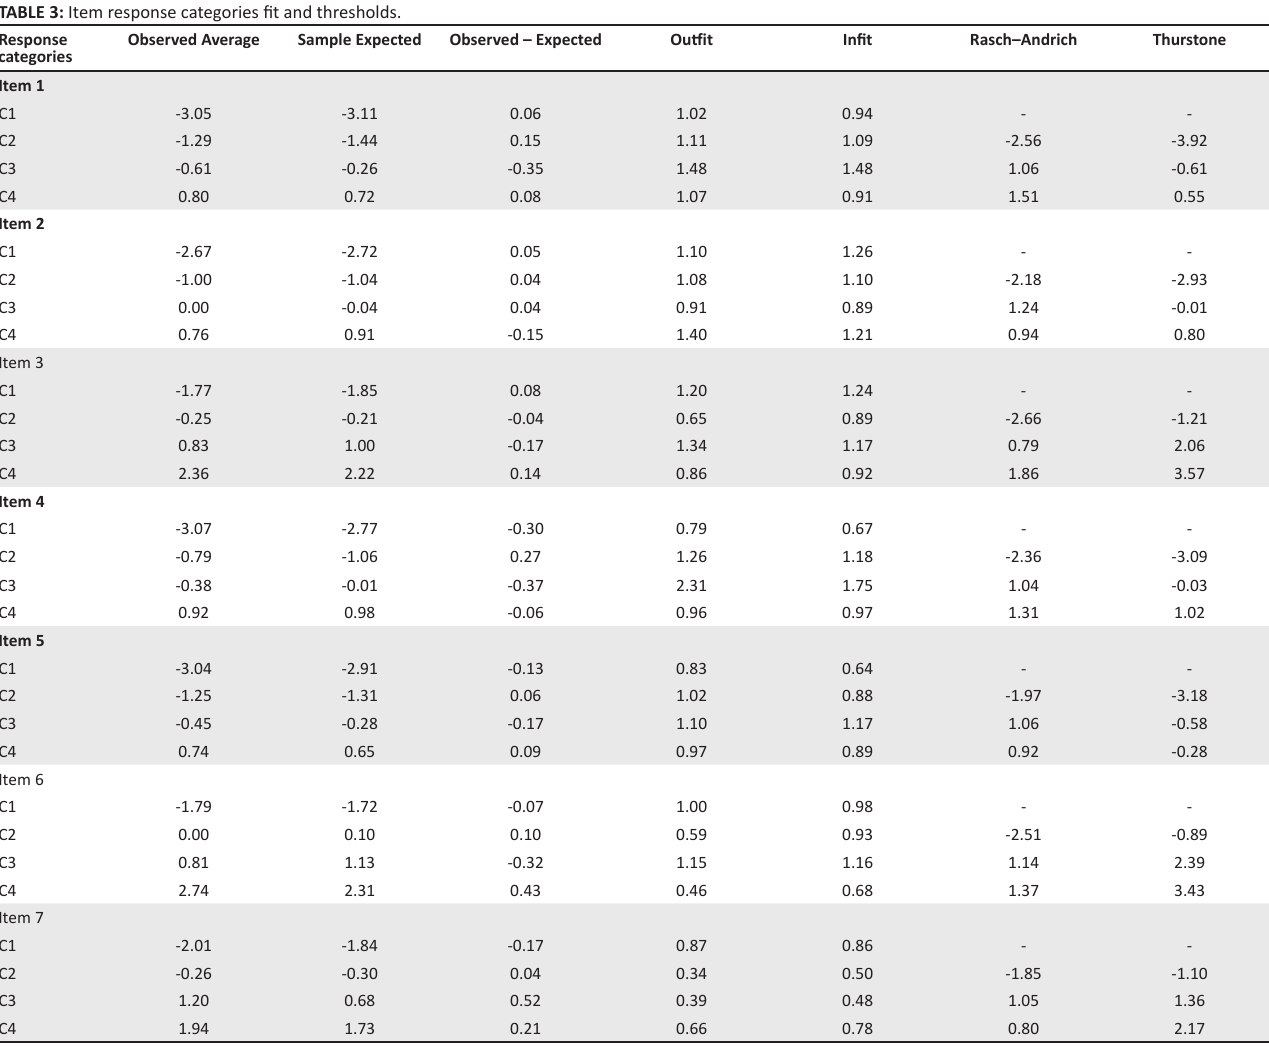
TABLE 3: Item response categories fit and